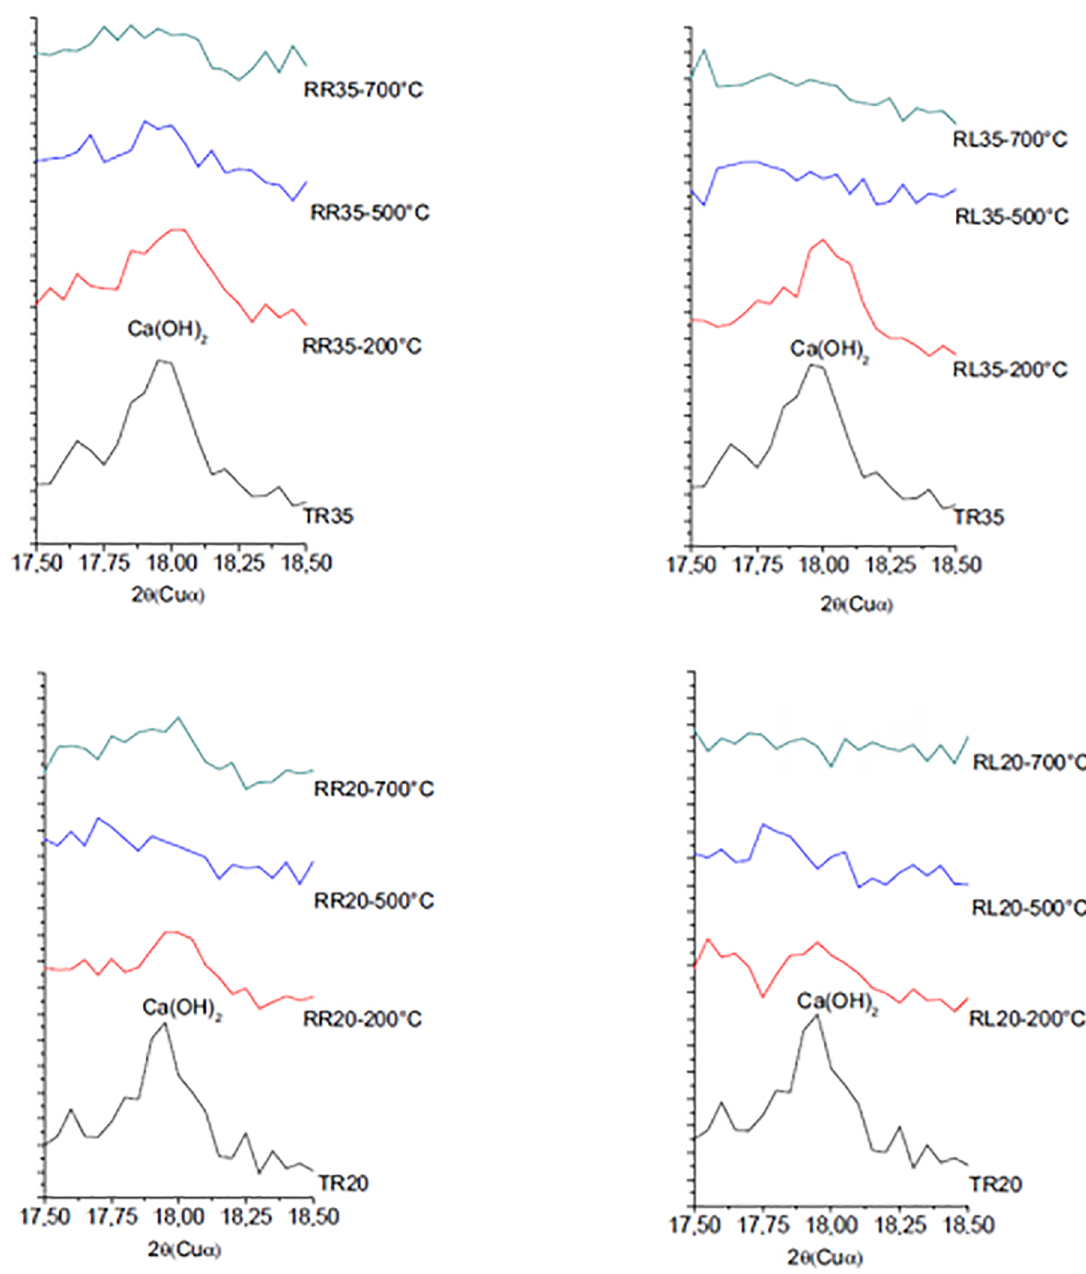
Figure 5. XRD of the evaluated